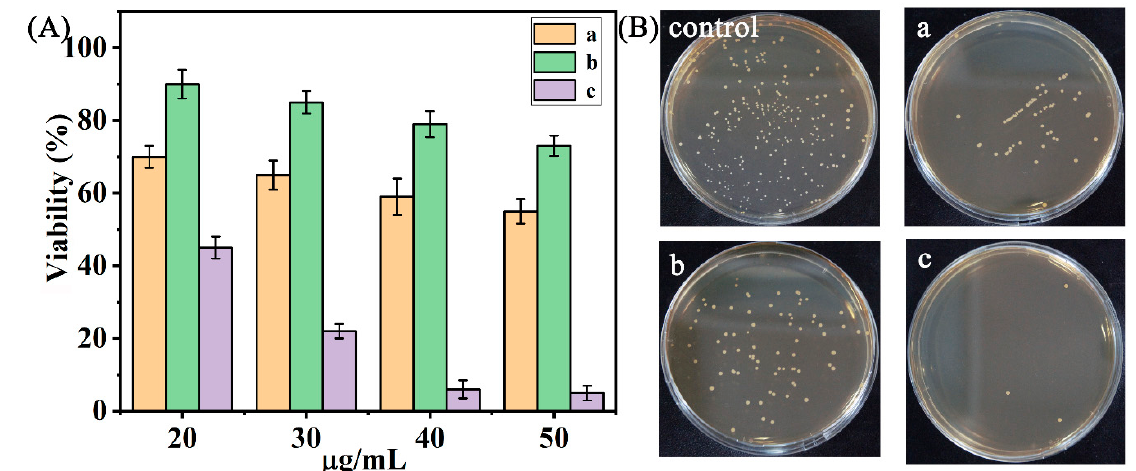
Figure 4. ( A ) E. coli viability under all different sample concentrations and ( B ) photographs of agar plates of E. coli incubated with 40 µ g/mL of UCNPs ( a ), R-TiO 2 ( b ), and UCNPs@R-TiO 2 nanocomposite ( c ) using a 980 nm laser (1 W, 12 min).